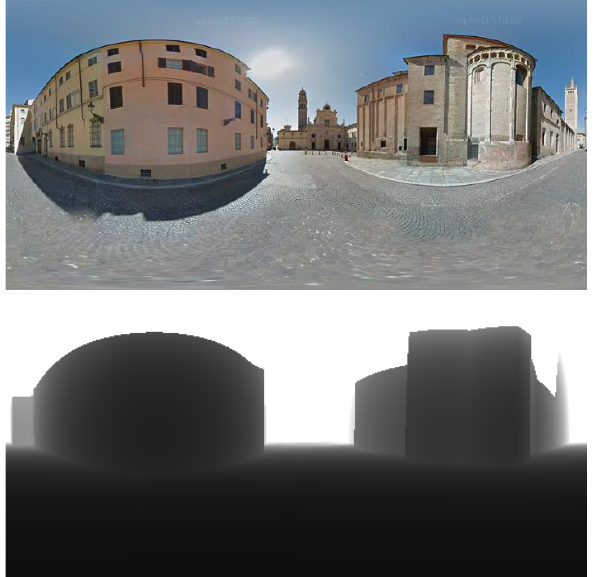
Figure 2_Equirectangular projection and associated depth map downloaded from Google .